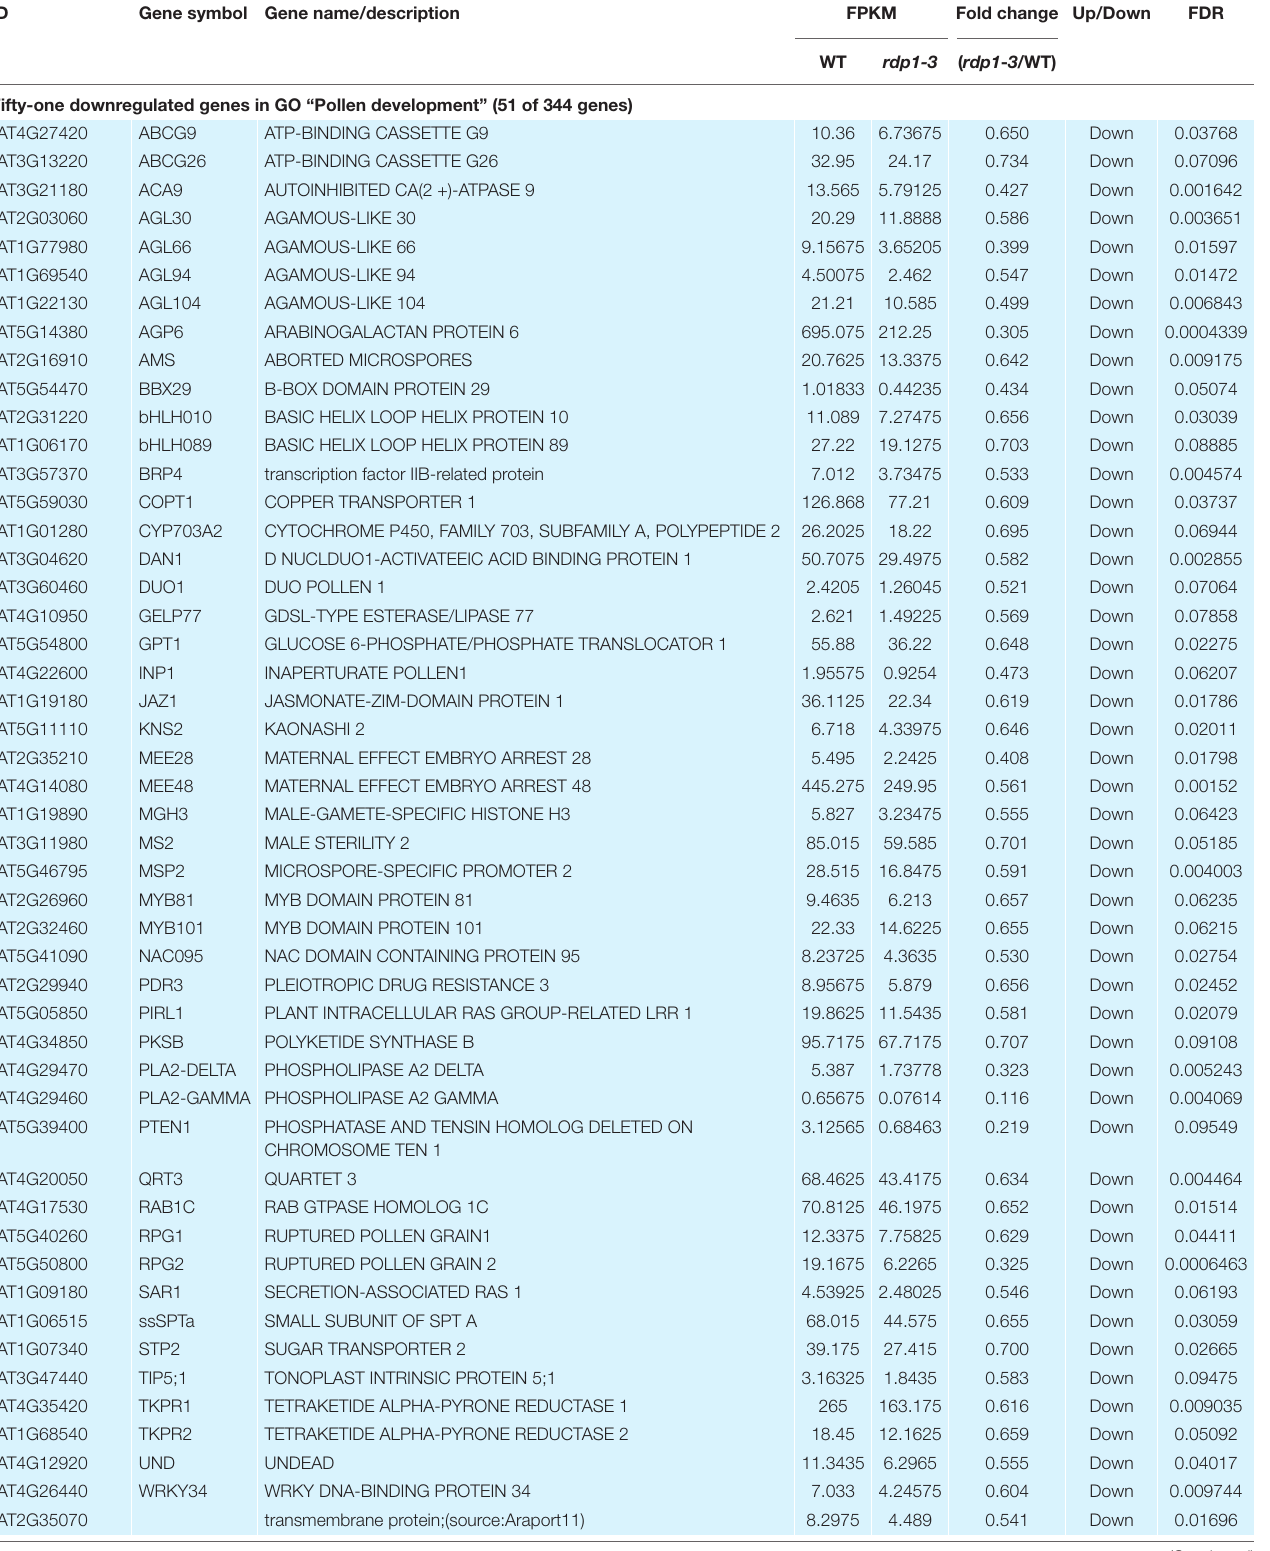
TABLE 2 | Downregulated pollen/anther development-related